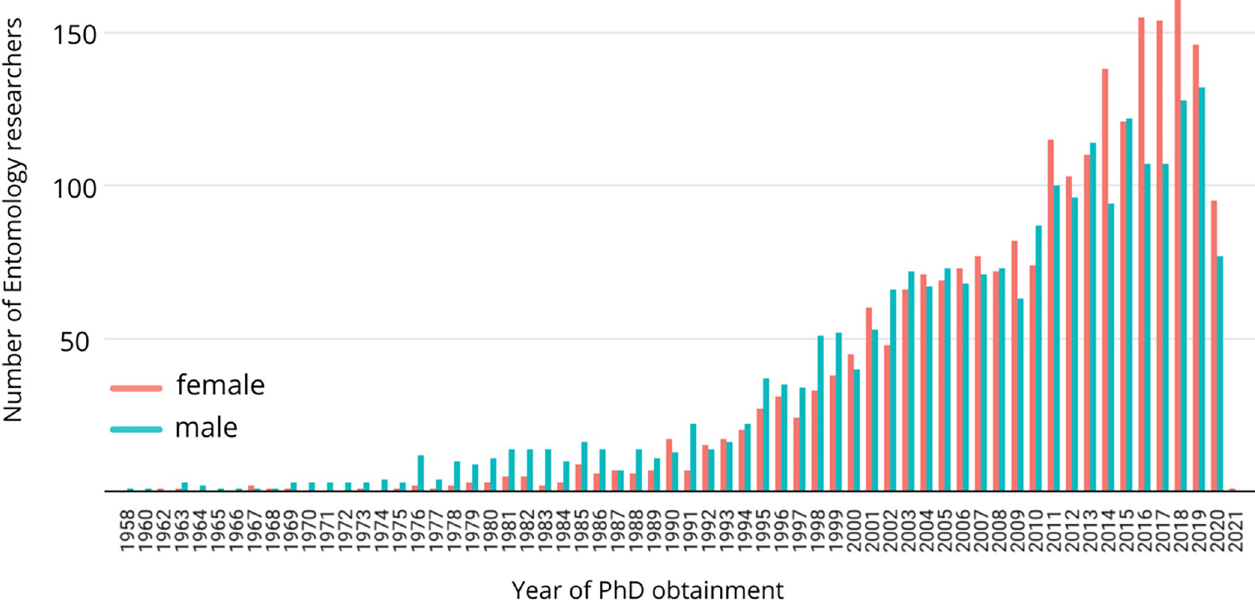
Fig 1. Total number of female and male researchers per year of degree (PhD) obtainment in the iAraucaria